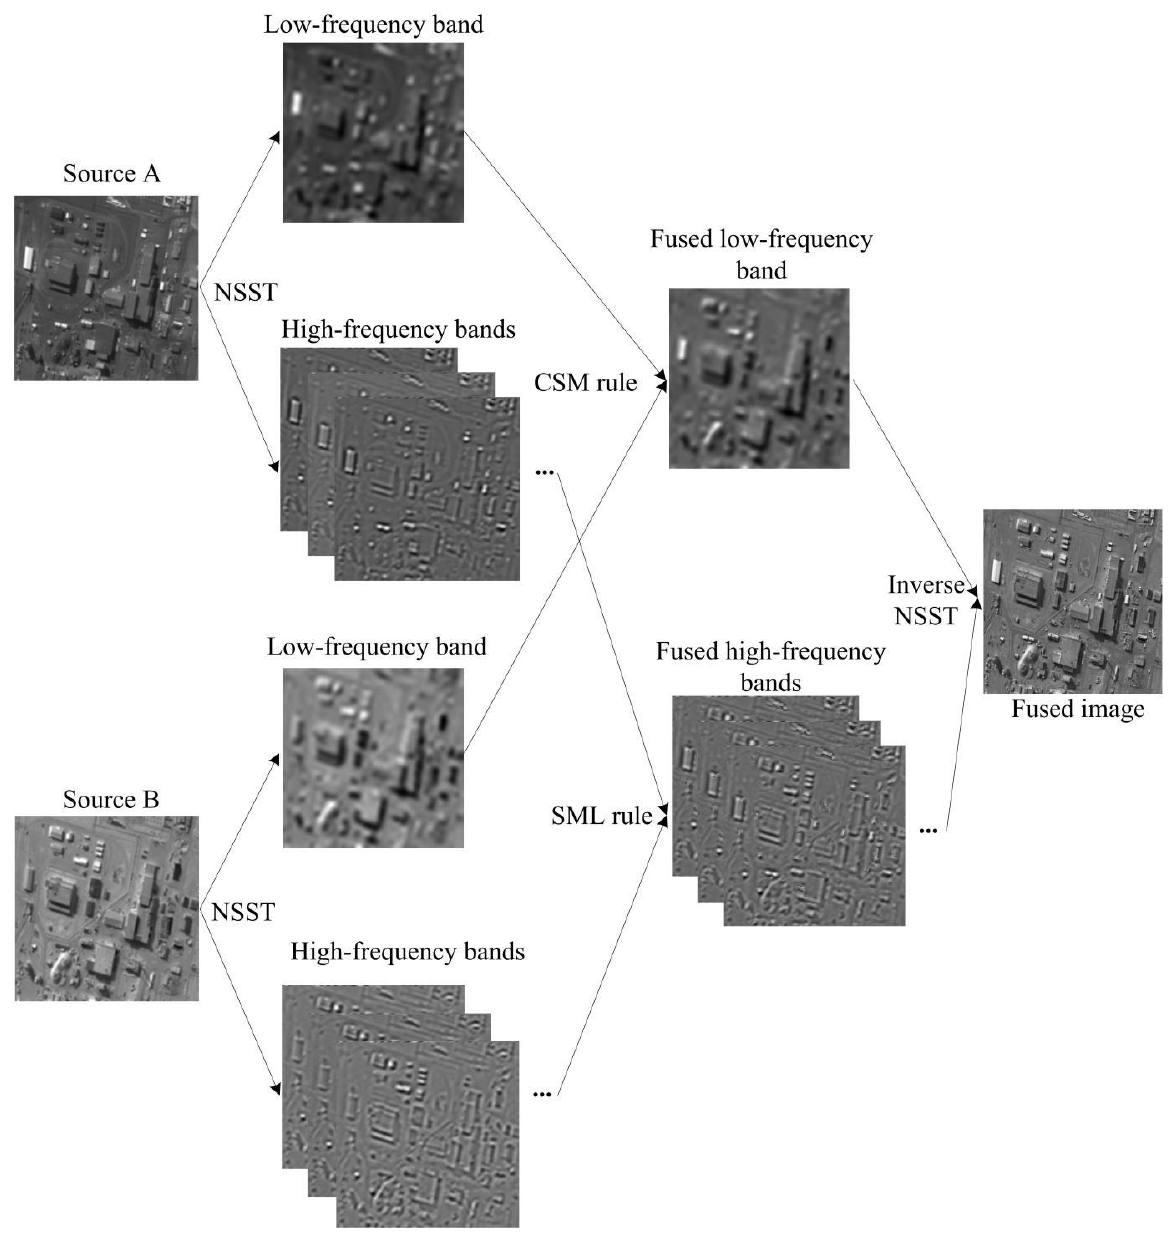
Figure 2. The flow chart of the proposed remote sensing image fusion method.